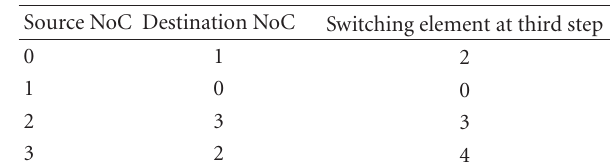
Figure 26: MTTF under repair of PNN and HXN along with the MTTF lower bounds. Table 16: Intermediate SE information while data moves from source NoC to destination NoC at third step of best case.